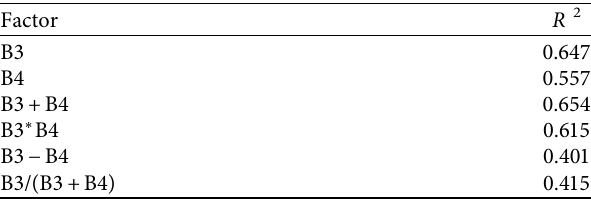
Table 4: Correlation index between PH and band.